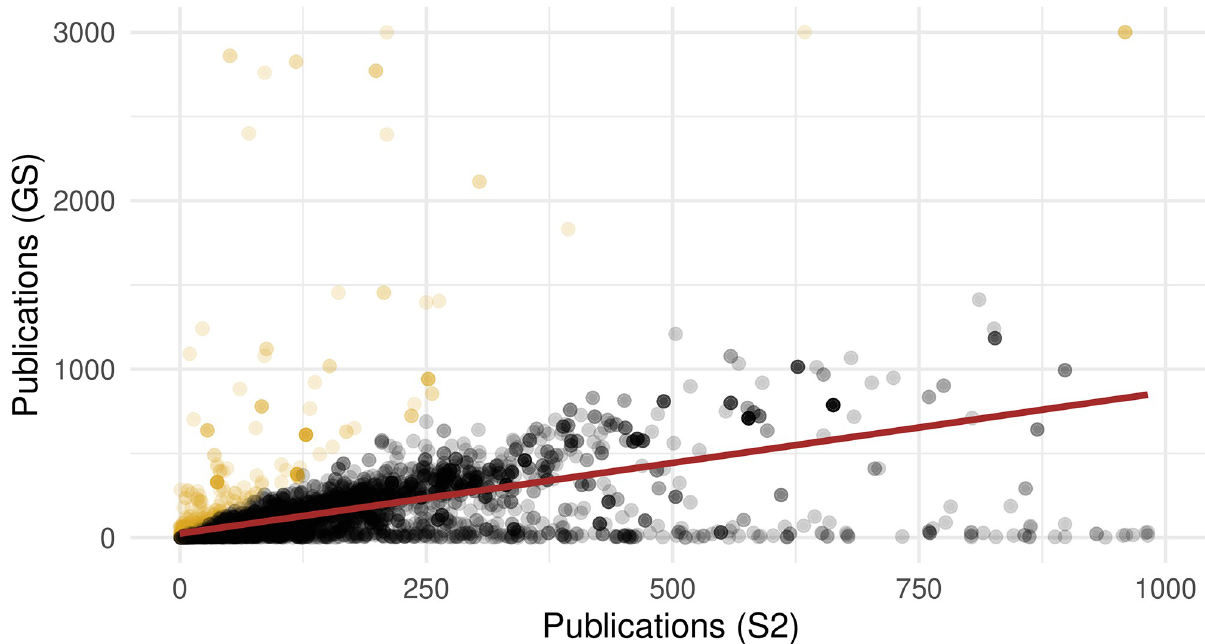
Fig 12. Scatterplot of the relationship between the two author-level, total publication metrics. The estimated linear regression line used for imputation is included in black and pointed where the GS metric is 3 times the S2 metric are highlighted in yellow.